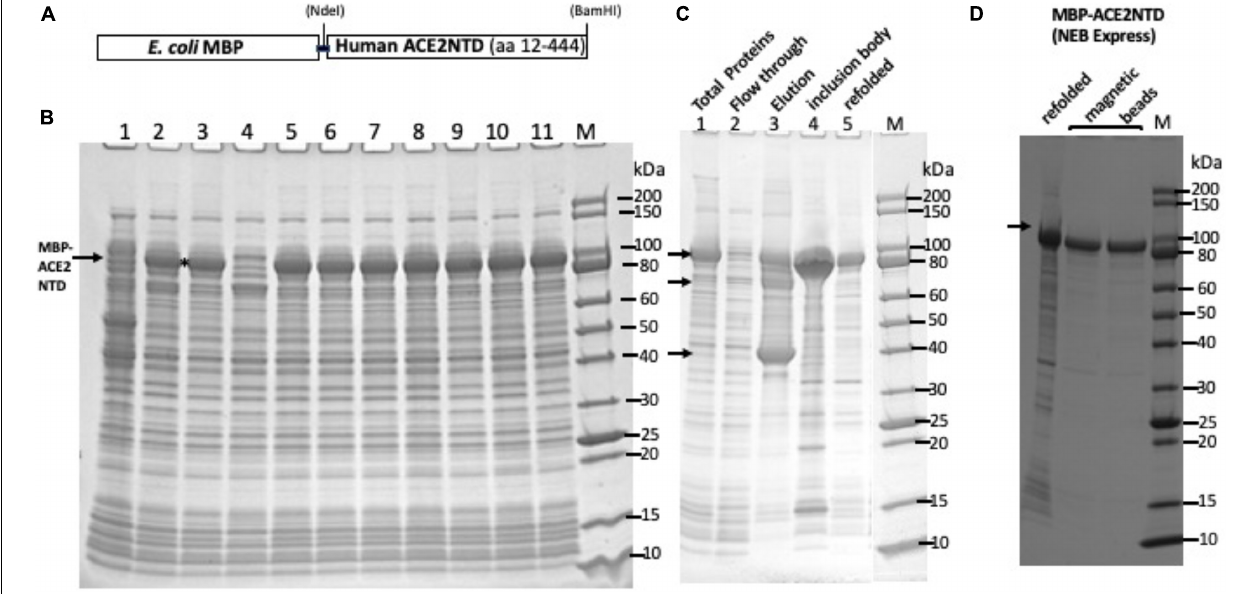
FIGURE 1 | SDS-PAGE analysis of maltose binding protein-angiotensin converting enzyme 2 N-terminal domain (MBP-ACE2NTD) fusion. (A) A schematic diagram of the fusion protein. (B) Total cellular proteins from IPTG-induced cells (NEB Express) containing the MBP-ACE2NTD fusion. Nine out of 11 clones tested here expressed the fusion (except #1 and #4). Clone #8 was chosen for further study. (C) MBP-ACE2NTD fusion expressed from IPTG induced cells (T7 Shuffle, lanes 1–4). Lane 1, total cellular protein; lane 2, flow-through from an amylose column; lane 3, eluted MBP-ACE2NTD protein from an amylose column; lane 4, MBP-ACE2NTD protein found in the pellet (inclusion body); lane 5, refolded MBP-ACE2NTD fusion protein from cell pellet (NEB Express); M, protein size marker (10–200 kDa, NEB). Arrows indicate the MBP-ACE2NTD protein, a truncated protein, and host MBP. (D) Purified MBP-ACE2NTD protein by amylose magnetic beads. Lane 1, refolded fusion; lanes 2 and 3, protein eluted in a Tris–HCl buffer (20 mM, pH 7.5) and sodium phosphate buffer (0.1 M, pH 8.0) with 10 mM